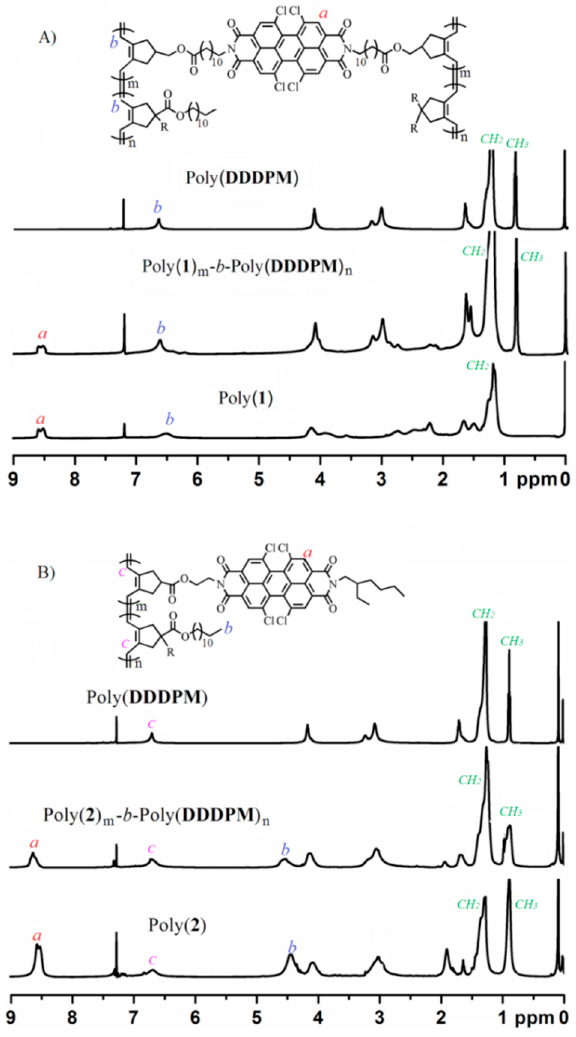
Figure 2. 1 H NMR spectrum of Poly( 1 )– b –Poly( DDDPM ) ( A ) and Poly( 2 )– b –Poly( DDDPM ) ( B ) in CDCl 3.